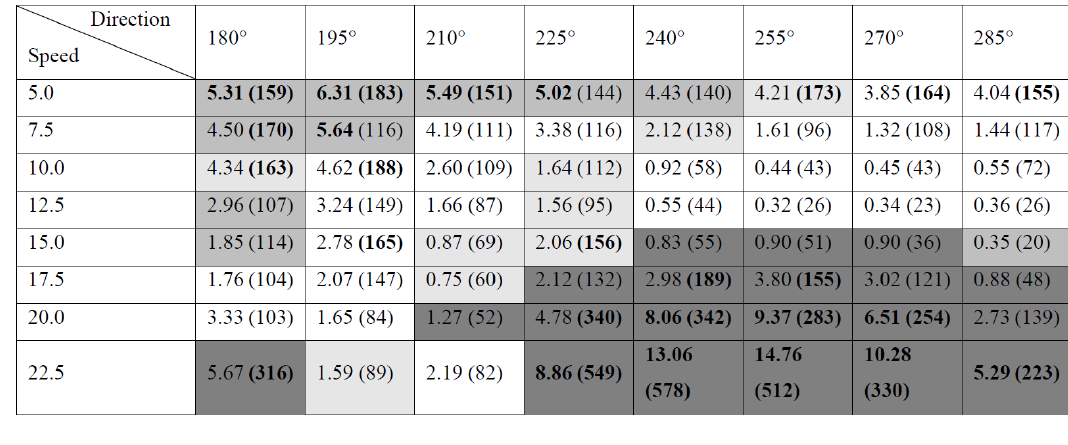
Table 4. The daily mean rainfall over Taiwan (mm) and the peak amount (parentheses) in the experiment set with prescribed southwesterly wind direction ( ◦ , column) and speed (ms − 1 , row). The areal-mean (peak) values ≥ 5 (150) mm are in boldface. Cells filled with light, medium, and dark gray and no color indicate that the peak amount (all in mountain elevation) occurs in the subregion of northern, central, southern, and eastern Taiwan (see Fig. 2b), respectively.